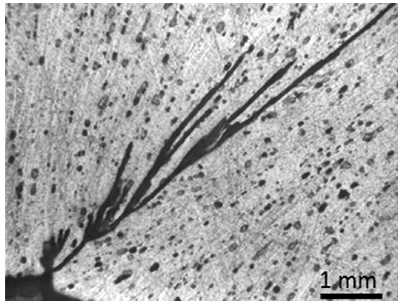
Fig. 6. Cross-cut of forging produced by Regime B showing cracks at the